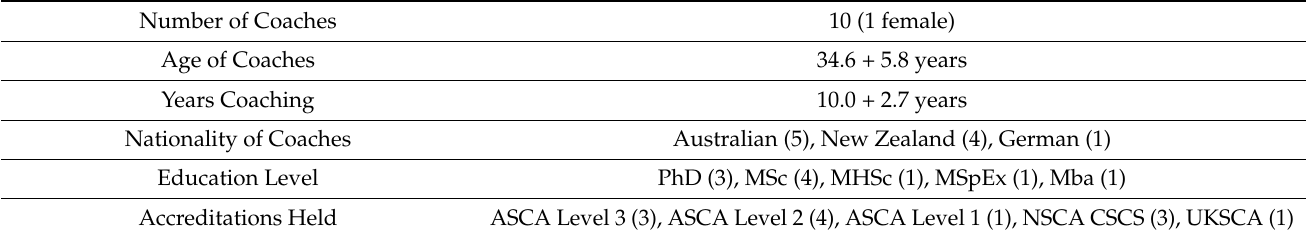
Table 1. Socio-demographic characteristics of HLCs interviewed.